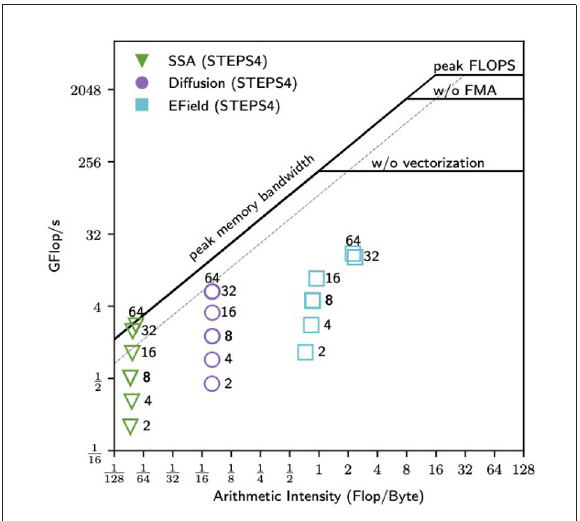
FIGURE12 Roofline single-node scaling trajectories. The solid black lines are the full node hardware limits and the dashed gray line is the peak memory bandwidth for one socket. Each data point is labeled by the number of processes. All the computational kernels present a low arithmetic intensity mainly due to not ideal data locality (not optimal cache utilization). Nevertheless, the scaling is close to ideal (especially for the SSA and Diffusion operators) given that the doubling of concurrency leads to a corresponding 1 y > 0. Hyper-threading at 64 cores does not give any substantial performance